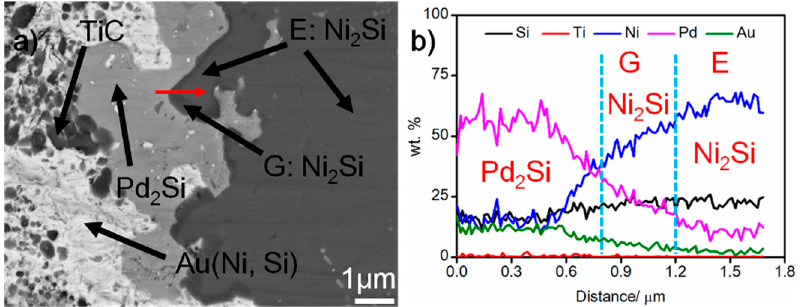
Figure 4. ( a ) SEM morphology of the braze seam, and ( b ) elemental distribution across the red scanning line in ( a ).